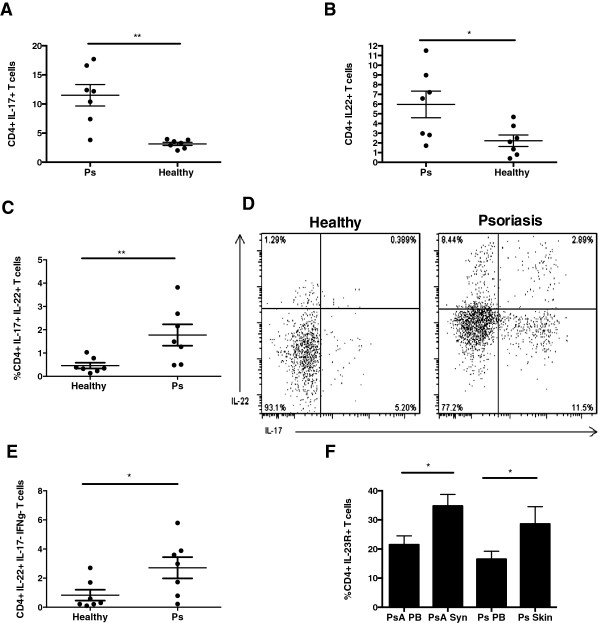
Frequency of IL-17+ and IL-22 + CD4+ in skin resident T cells of psoriatic skin lesions compared to healthy skin and interleukin 23 receptor coexpression in skin, synovial fluid and peripheral blood of psoriasis and psoriatic arthritis patients. Frequency of interleukin 17-positive (IL-17+) and IL-22+CD4+ in psoriatic skin lesions compared to healthy skin (A) and (B). Frequency of IL-17+IL-22+CD4+ T cells in psoriatic skin lesions compared to healthy skin (C). Representative fluorescence-activated cell sorting plots demonstrating CD4+ T-cell expression of IL-22 and IL-17 in psoriatic versus healthy skin (D). Percentages of Th22 cells in psoriatic and healthy skin (E). Percentage of CD4+ T cells coexpressing IL-23 receptor (IL-23R) in paired synovial fluid (Syn) and peripheral blood (PB) from psoriatic arthritis (PsA) patients and in skin and PB of psoriasis (Ps) patients (F). * p<0.05, **p<0.01, ***p<0.001.